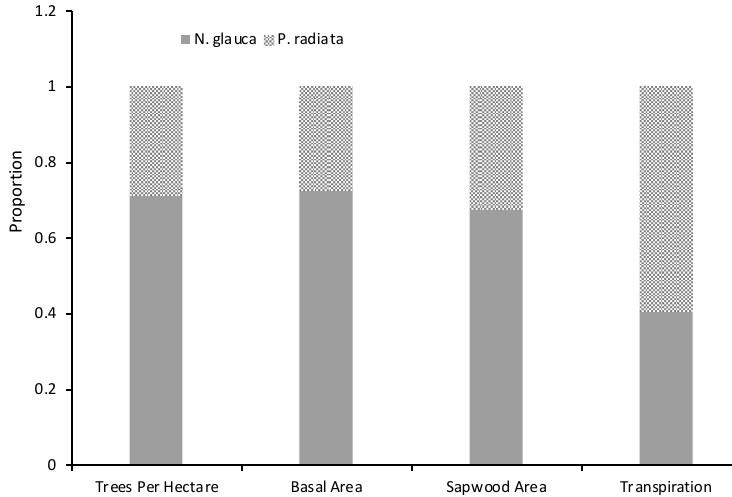
Figure 5. The proportion of the trees and stand basal area, sapwood area and transpiration contributed by P. radiata and N. glauca in this mixed stand.